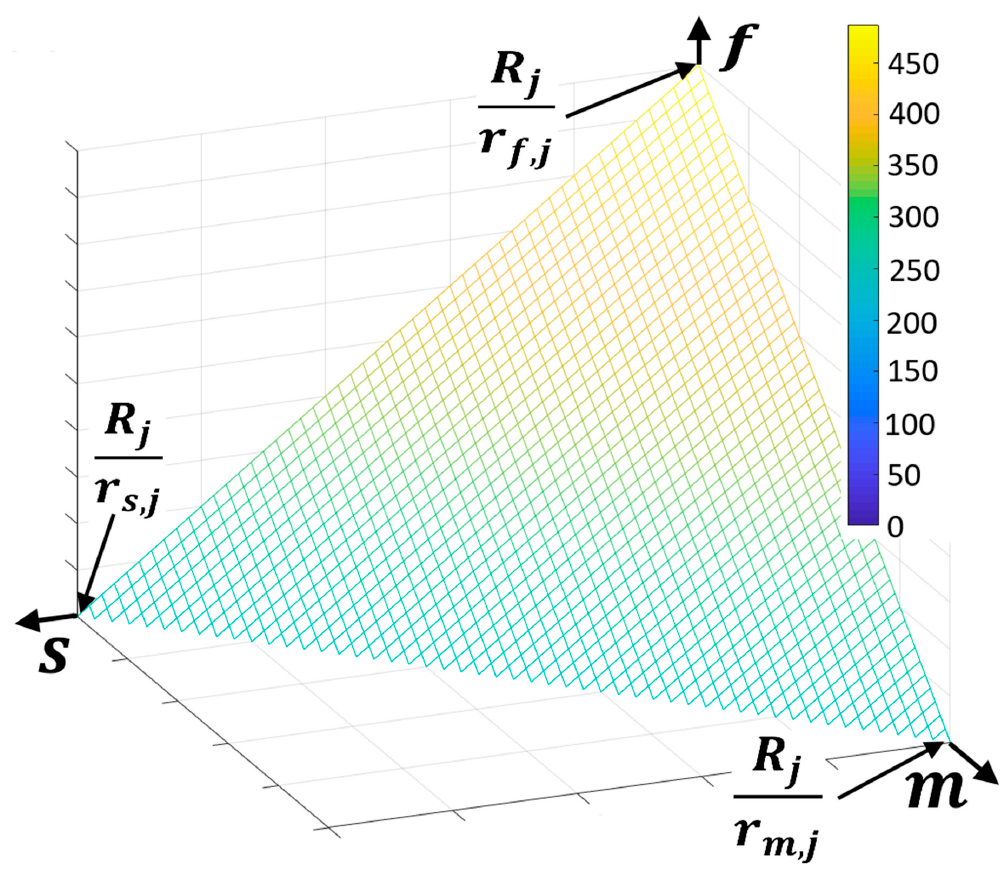
Figure 7. An example of the space of solutions as calculated by the model with highlighted boundaries.